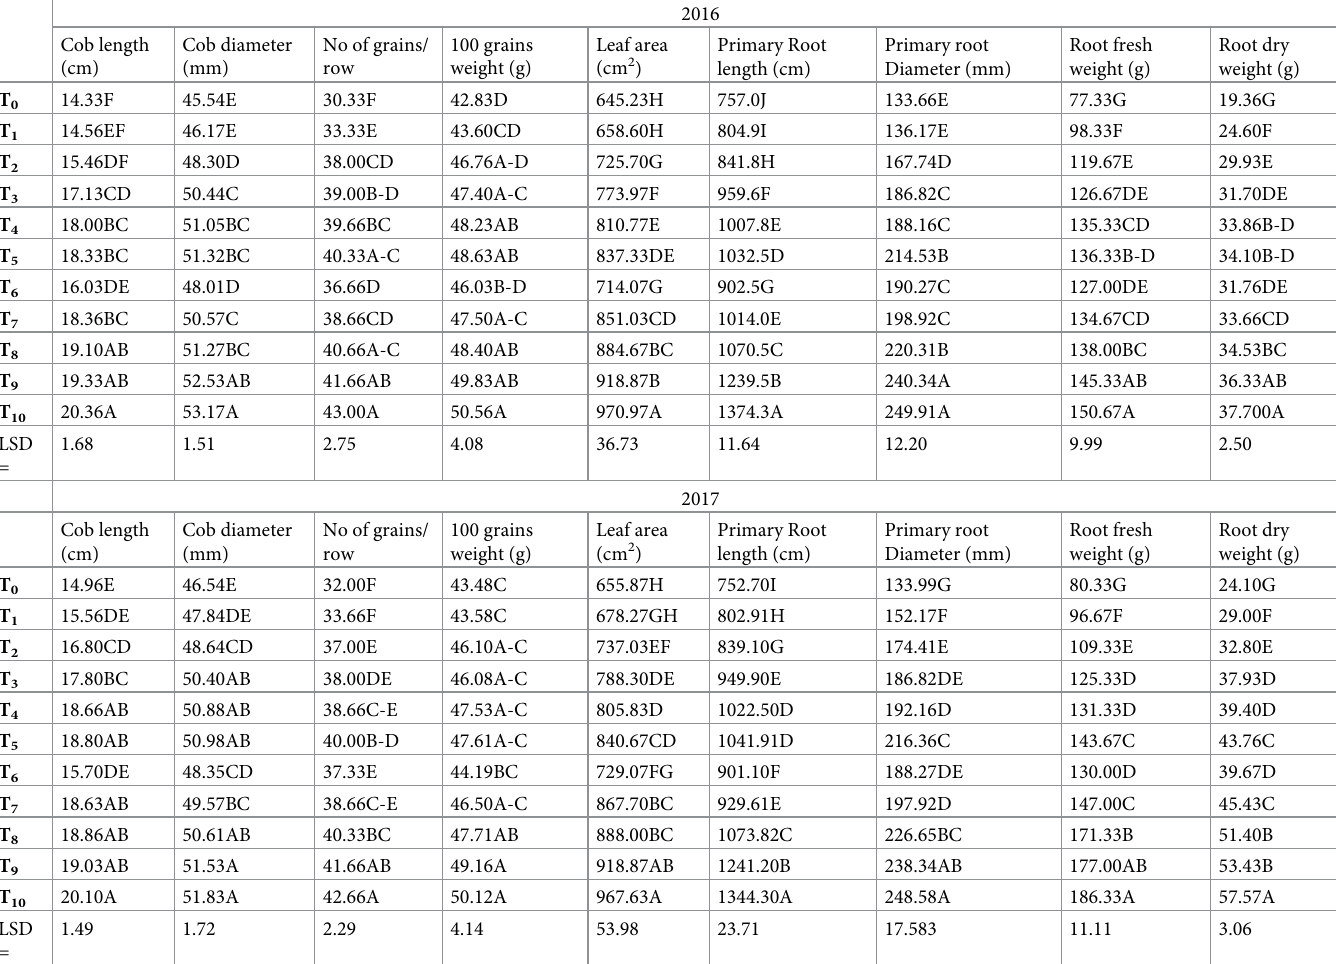
Table 2. Effect of Zn-lysine chelate along with inoculation with consortium of highly Zinc Solubilizing Bacteria on Zn distribution in different parts of maize, grain yield and biological